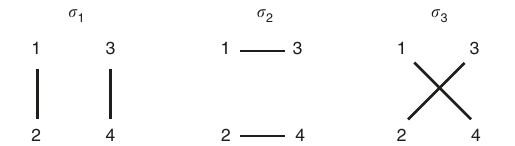
Fig. 2 Illustration of a set of edge-disjoint perfect matchings for size n = 4. The matching set M 4 has three edge-disjoint perfect matchings: [ σ 1 :{(1, 2), (3, 4)}; σ 2 :{(1, 3), (2, 4)}; σ 3 :{(1, 4), (2, 3}]